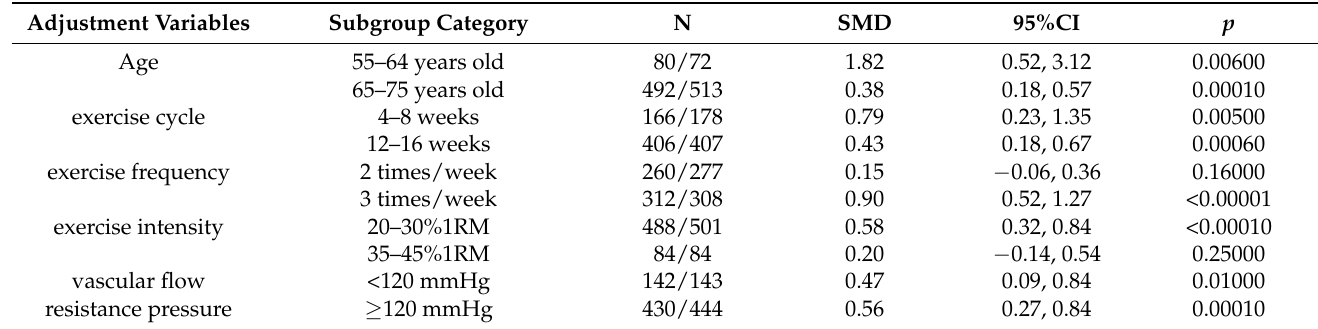
Table 4. A subgroup analysis of the effects of low intensity resistance training with blood flow restriction on lower limb muscle strength in middle-aged and older adults.